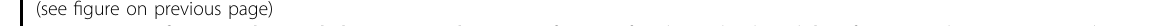
Fig. 1 MPXV infection in human kidney organoids. a Quanti fi cation of viral DNA levels and ( b ) infectious viral titers in organoids ( n = 4). c Quanti fi cation of viral DNA levels and ( d ) infectious viral titers in the culture medium ( n = 4-6). e Visualization of MPXV by immunostaining organoids with an antibody against the virions (green). Blue is DAPI staining of nuclei. Scale bar: 200 μ m. f Transmission electron microscopy visualized the MPXV particles in organoids. Scale bar: left, 2 μ m; right, 1 μ m. g The assembly steps of MPXV start from crescents (Cs), proceed to immature virions (IVs), and fi nally form the mature virions (MVs). Scale bar: 200 nm. h The percentages of mapped MPXV transcripts in infected organoids. i MPXV transcripts mapped to the locations in viral genome. j The top 30 signi fi cantly regulated genes by MPXV infection. k Top 30 signi fi cantly regulated pathways by gene ontology analysis at day 7 post-inoculation, compared with the uninfected group. Red: upregulated; blue: downregulated. l Immunohistochemical staining of kidney organoid sections for glomerular structures (PODXL), proximal tubular structures (Villin-1), distal tubular structures (E-cadherin) and endothelial structures (PECAM-1) at 1 h, 48 h, 96 h and 7 d after inoculation with MPXV. m Quanti fi cation of MPXV DNA level in organoids ( n = 4) and ( n ) culture medium ( n = 4) 7 days after tecovirimat treatment. o Quanti fi cation of infectious titters in culture medium 7 days after tecovirimat treatment. Infectious titers were undetectable in the treatment groups ( n = 4). p Cell viability of kidney organoids after treatment by tecovirimat for 7 days ( n = 4 – 5). h: hour post-inoculation; d: day post-inoculation. Data are presented as means ± SEM. * P < 0.05, Mann – Whitney